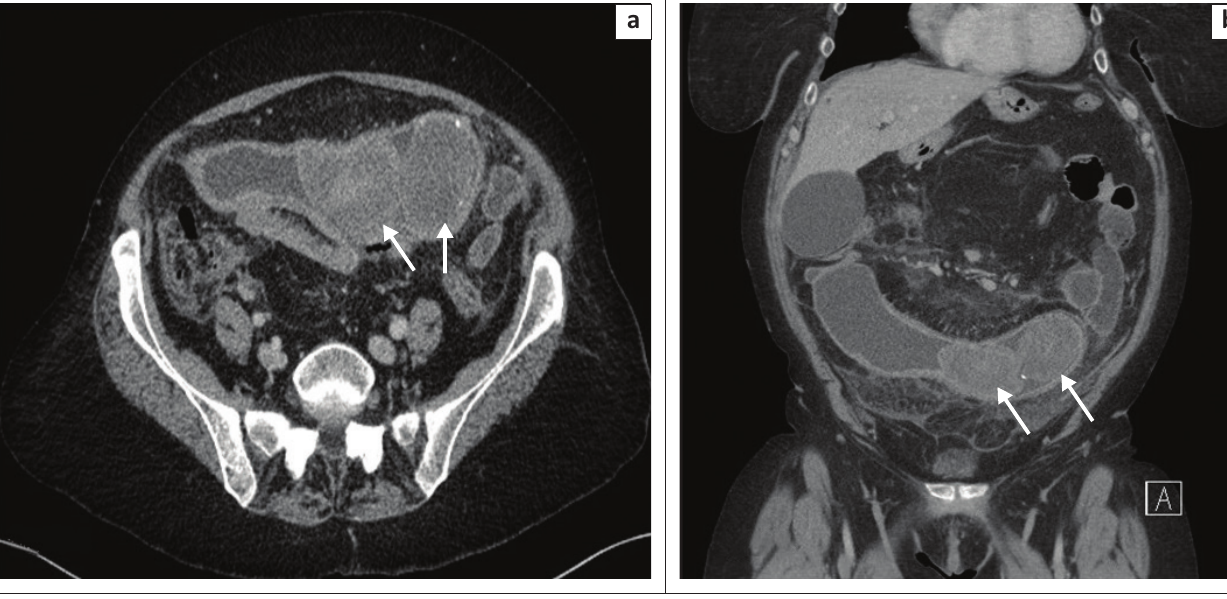
FIGURE 10: (a) Axial and (b) coronal reformatted computed tomography images of a 64-year-old woman with a history of Crohn’s disease. Computed tomography showed two intraluminal masses (arrows) with peripheral calcifications located within a dilated loop of distal jejunum. There was associated upstream small bowel obstruction. The patient underwent small bowel resection with primary anastomosis, and pathological evaluation of the excised specimen confirmed the intraluminal masses as